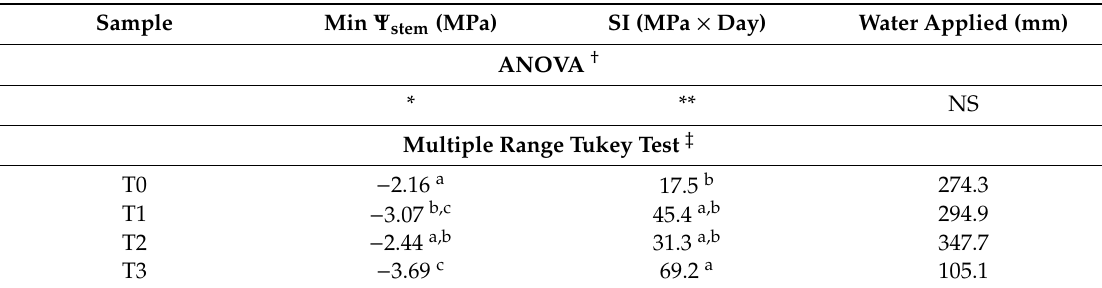
Table 1. Minimum midday stem water potential (min Ψ stem ), water stress integral (SI) and water applied as a ff ected by the irrigation